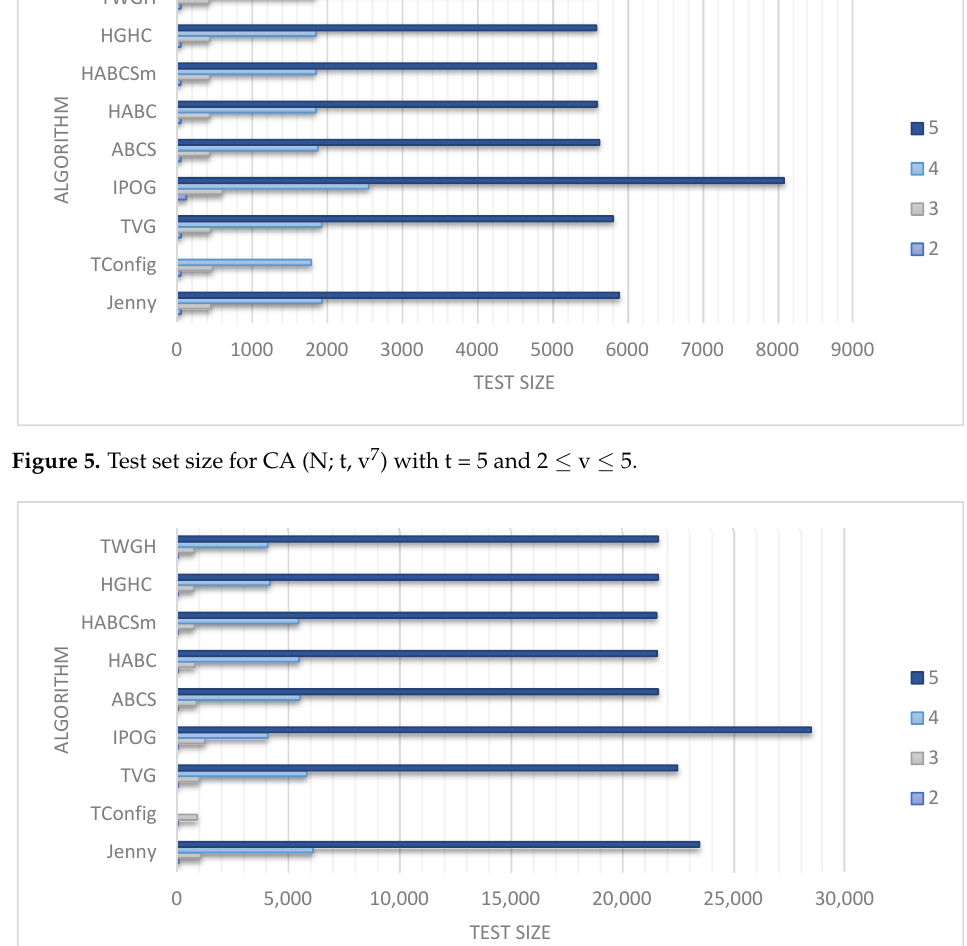
Figure 5. Test set size for CA (N; t, v 7 ) with t=5 and 2 ≤ v ≤ 5.